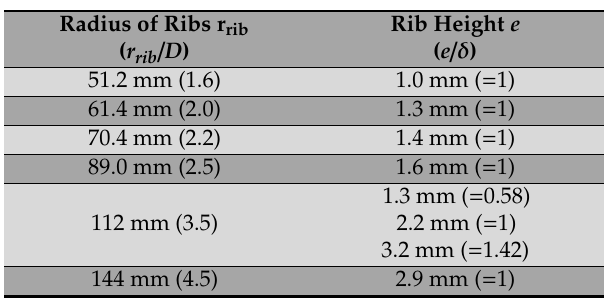
Table 1. Dimensions of circular